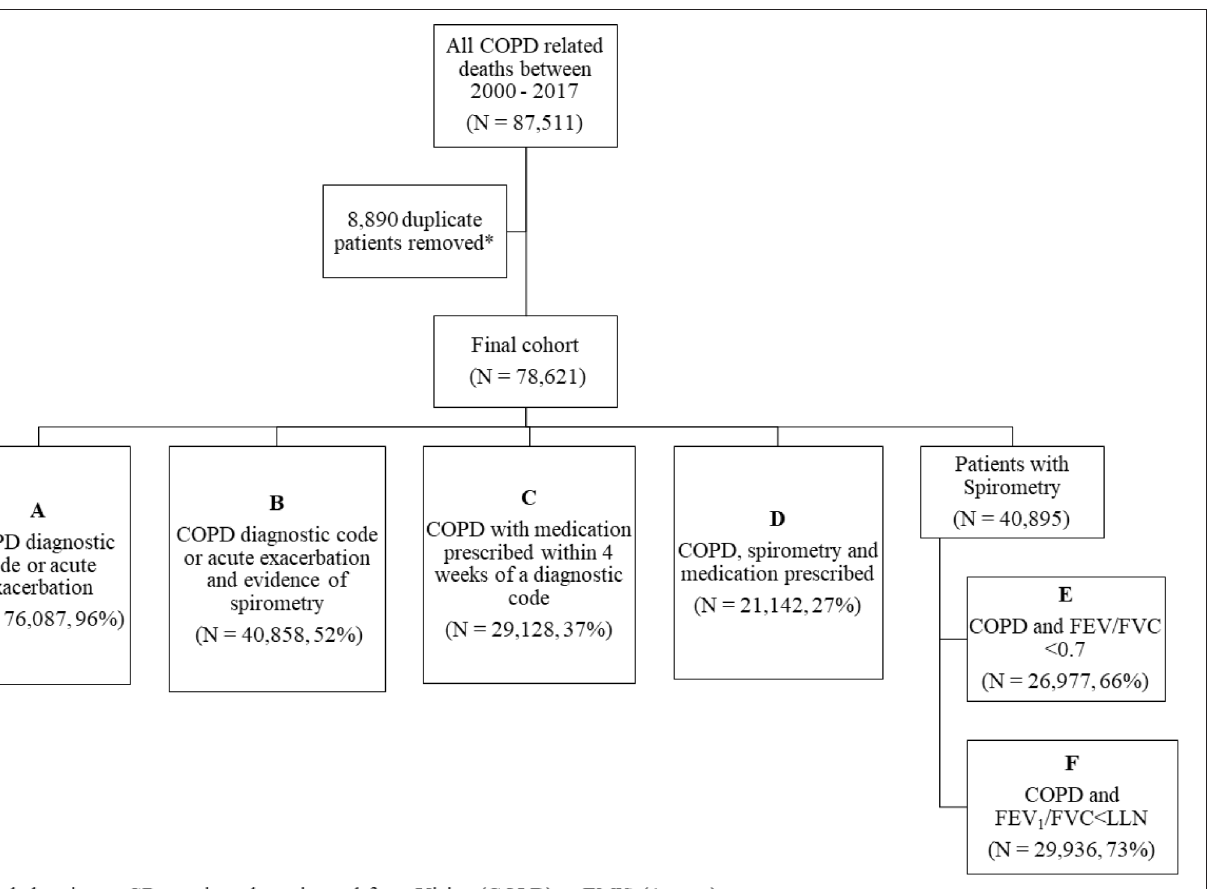
Figure 2 Proportion of patients with evidence of chronic obsructive pulmonary disease (COPD) by diagnostic criteria. FEV/FVC = forced expiratory volume/forced vital capacity. LLN = lower limit of